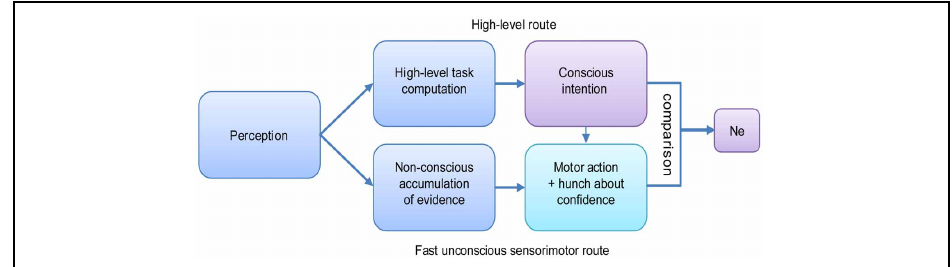
FIGURE 3 | The dual-route model of decision making, based on Del Cul et al. (2009) as expanded by Charles et al.